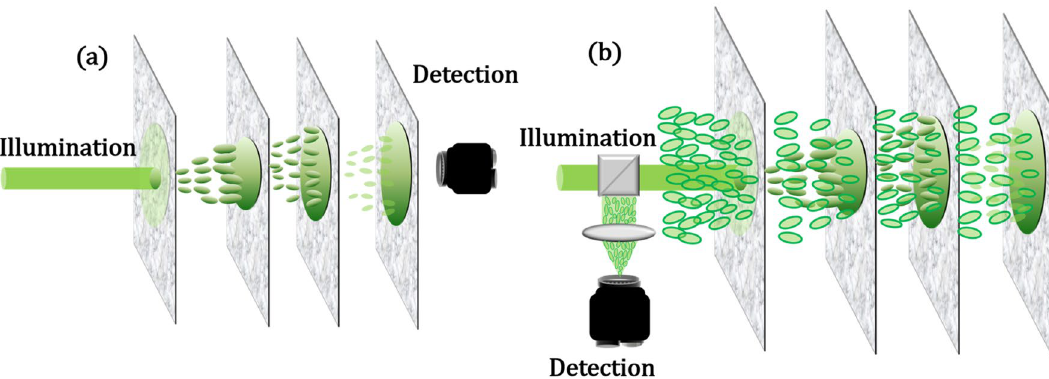
Figure 1. Schematic description of the proposed non-invasive technique for imaging through a scattering media ( a ) the conventional technique vs ( b ) Our technique that requires no feedback nor camera behind the media as in ( a